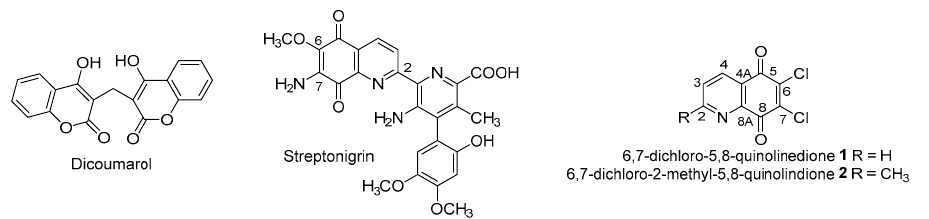
(Figure 1). The high toxicity of streptonigrin ( ST ) prevents its use in cancer treatment [17– 20].